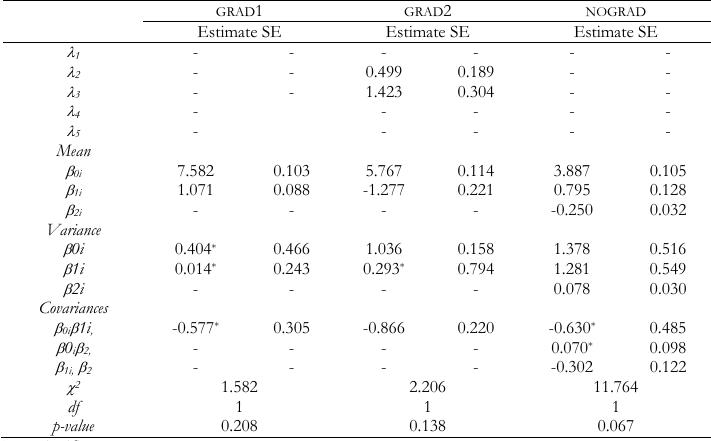
Parameter estimation for the unconditional models, GRAD1, GRAD2, NOGRAD GRAD 1 GRAD 2 NOGRAD Estimate SE Estimate SE Estimate SE λ